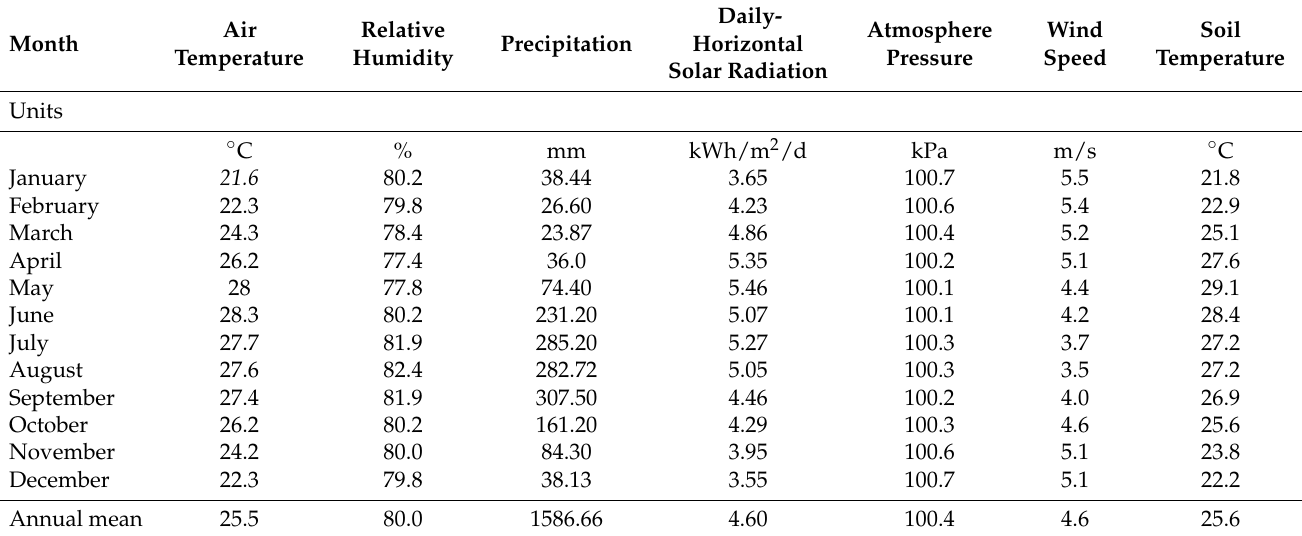
Table 3. Meteorological data and solar radiation at the study site, obtained with Retscreen ®